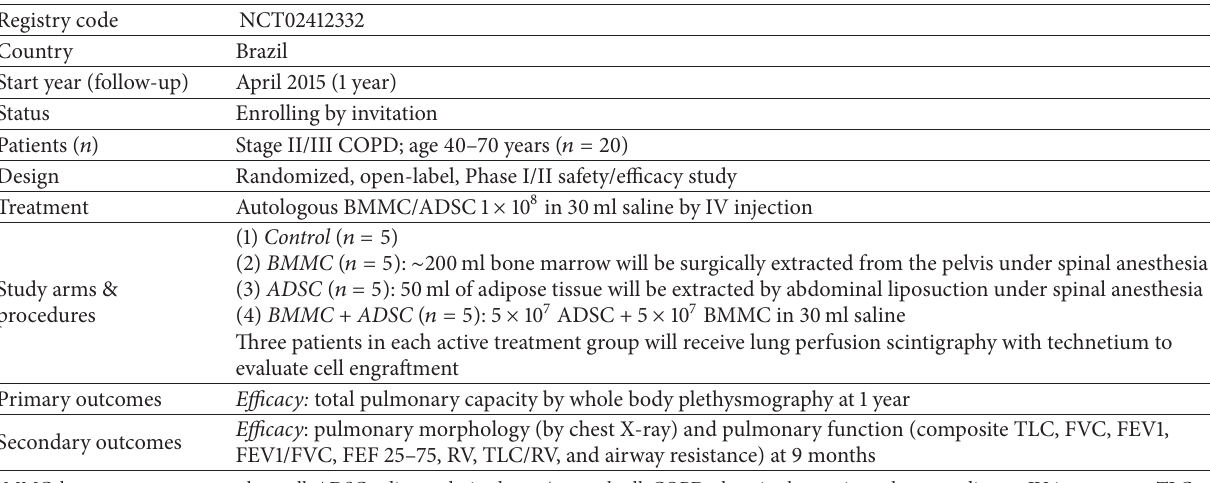
Table 5: Ongoing clinical trials comparing BMMC and ADSC therapy in